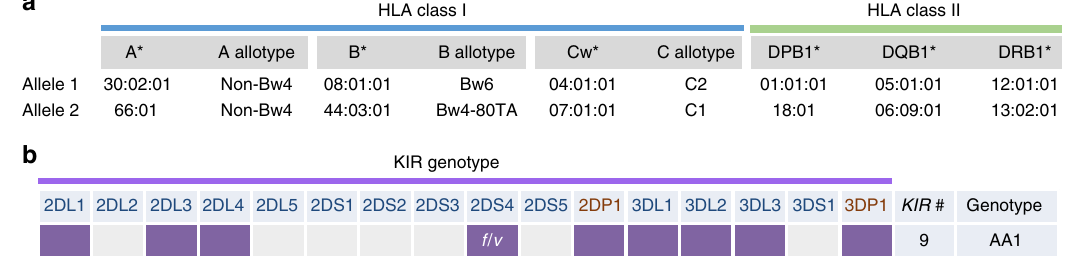
Fig. 4 HLA class I and II alleles and KIR genotype. a HLA class I A, B and C with corresponding allotype designations (non-Bw4, Bw6, Bw4-80TA, C1 and C2), and HLA class II DPB1, DQB1 and DRB1 alleles are indicated as allele 1 and 2. HLA B*44:03:01 has a threonine (T) at position 80 as part of the Bw4 epitope (NLRTALR) of the α 1 helix 2 of the molecule — and therefore will bind to KIR3DL1 on NK cells. HLA- Cw*07:01:01 (allotype C1) and Cw*04:01:01 (C2) have a lysine (K) and asparagine (N) at position 80, respectively — allowing for interaction with both KIR2DL3 (C1) and 2DL1 (C2) on NK cells. b The presence (coloured box) or absence of 16 KIR genes (14 functional and 2 pseudogenes 2DP1 and 3DP1 ) is shown. The child has an AA1 genotype, which has 9 KIR genes, has 2 copies of KIR3DL1 and 2 copies of activating gene KIR2DS4 with one full-length ( f ) and one truncated ( v ) version (heterozygous f/v ). 2D: 2-domain; 3D: 3-domain; L: long tail, inhibitory; S: short